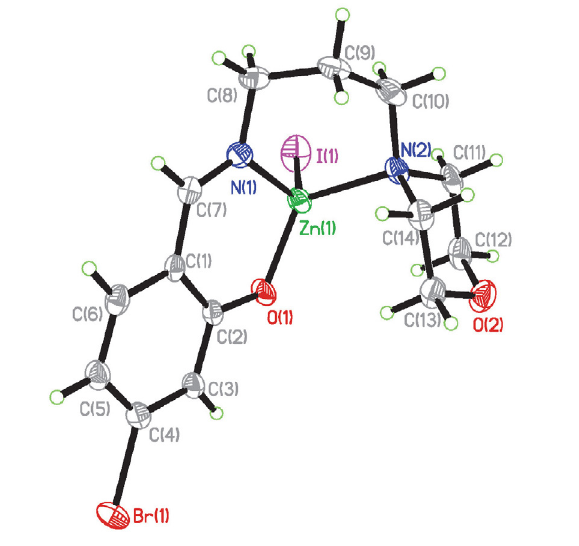
Figure 5. Molecular structure of complex 3